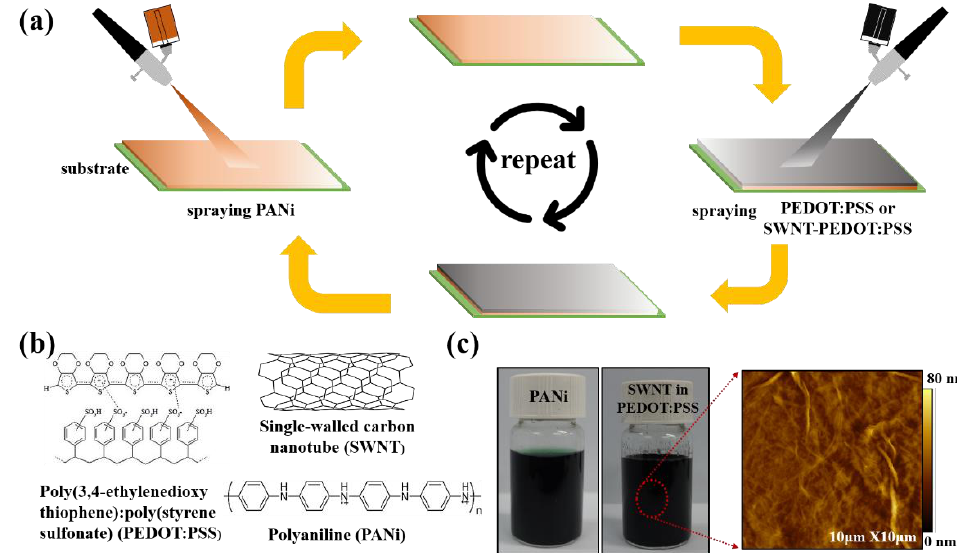
Figure 1. ( a ) Illustration for fabrication process of LbL-thermoelectric nanocomposites via spray ap- proach, ( b ) chemical structures of PEDOT:PSS, SWNT, and PANi used in this study, and ( c ) photo- graph of PANi and SWNT, stabilized in PEDOT:PSS, along with a corresponding AFM image that shows uniformly dispersed SWNT in PEDOT:PSS solution.